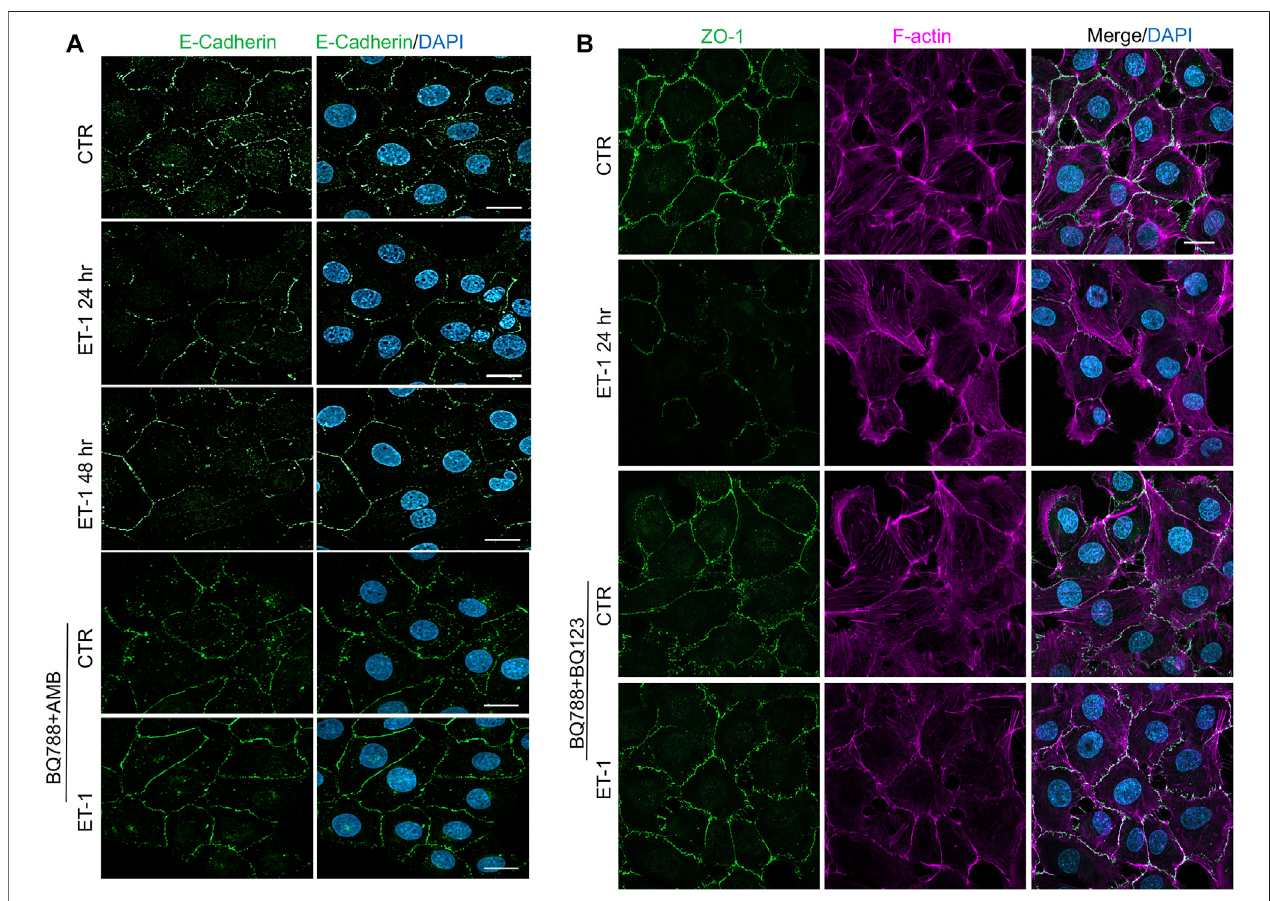
FIGURE 4 | ET-1 induces loss of E-cadherin and ZO-1 through ET A R/ET B R. (A) Representative images of IF analysis of MCs stimulated with ET-1 and/or BQ788+AMB for 48 h. Cells are stained for E-Cadherin (green), and DAPI (blue). (B) IF analysis of MCs stimulated with ET-1 and/or BQ123+BQ788 for 24 h. Cells were stained for F-actin (violet), ZO-1 (green) and DAPI (blue).